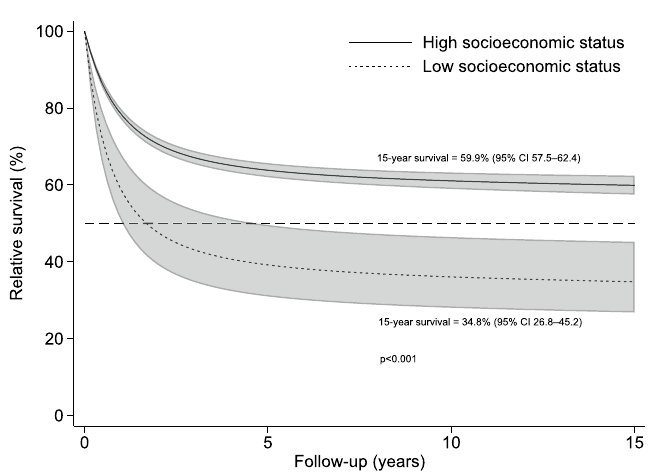
Figure 2. Secular trends of the probability of receiving ( a ) chemotherapy and ( b ) rituximab respectively among DLBCL patients by SES in Hong Kong, 2000–2018 (N = 4017). The light grey bands represent the 95% confidence interval bands. SES socioeconomic status.